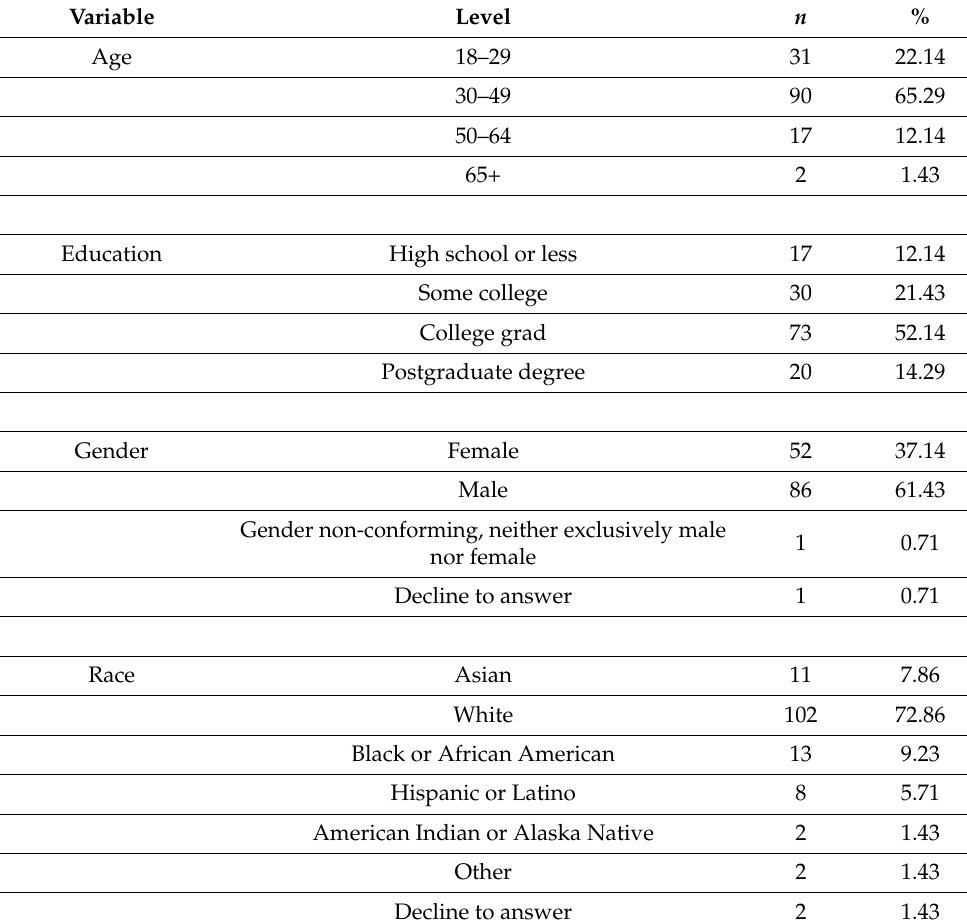
Table 1. Participants’ demographics.